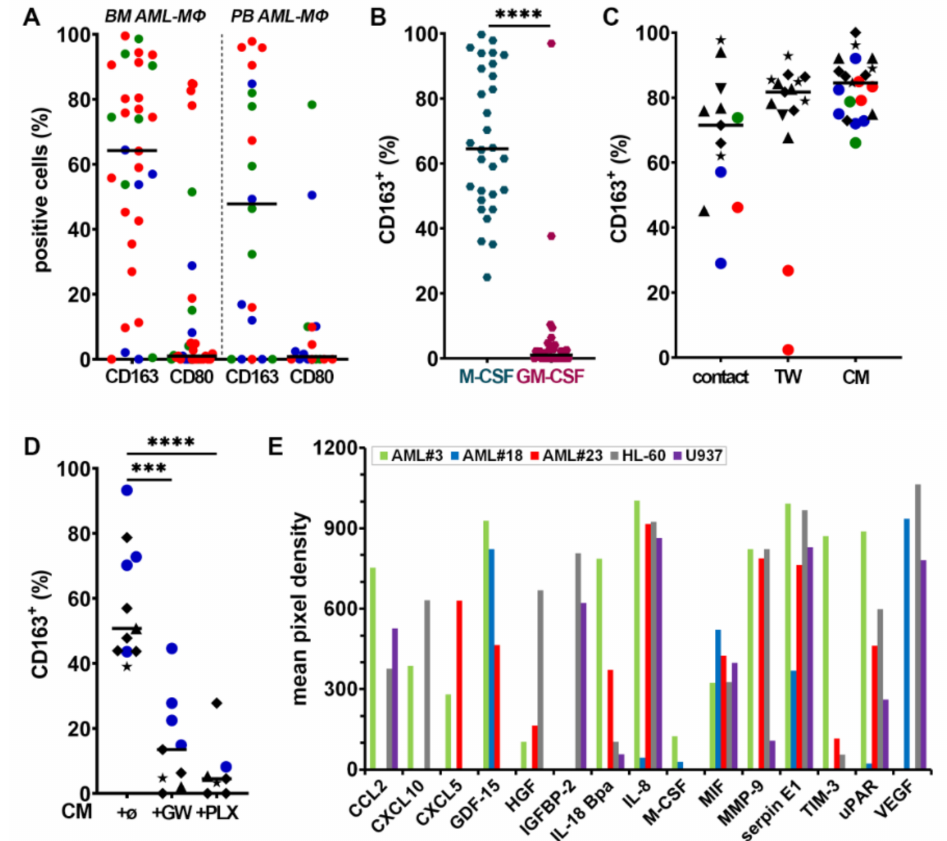
Figure 1. CD163 expression on M Φ s is modulated by stimuli and depends on CSF1R activity ( A ) Expression frequency of CD163 and CD80 in BM and/or PB of 42 AML patient M Φ s (within CD14 + /CD45 + gate) at diagnosis. Each patient is color-coded according to ELN genetic risk (green = favorable, blue = intermediate, and red = high risk). The median is indicated by a black horizontal line. ( B ) Expression frequency of CD163 in HD M Φ s after one week of culture in PM supplemented with M- or GM-CSF, n = 30. ( C ) CD163 expression allogeneic HD AML -M Φ s obtained from monocytes cultured with AML cell lines ( (cid:70) = HL-60, (cid:78) = NB4, (cid:7) = U937, and (cid:72) = OCI-AML3) or primary patient blasts (dots color-coded according to genetic risk) either in direct contact or separated with a TW. AML conditioned medium (CM) was also tested. The median is indicated by a black horizontal line, n = 13–21. ( D ) HD Mo were cultured for 7 days with primary patient blasts (blue) or leukemia cell lines (symbols) CM, supplemented with GW2580 (GW) or PLX3397 (PLX) before analyzing CD163 expression by FC. CM from: (cid:70) = HL-60, (cid:78) = NB4, and (cid:7) = U937, blue dot = patient#18; n = 3–6 HD. ( E ) Relative quantification of selected cytokines secreted by patient blasts with three different genetic risks and two leukemia cell lines. *** p < 0.001 and **** p < 0.0001 (M-W